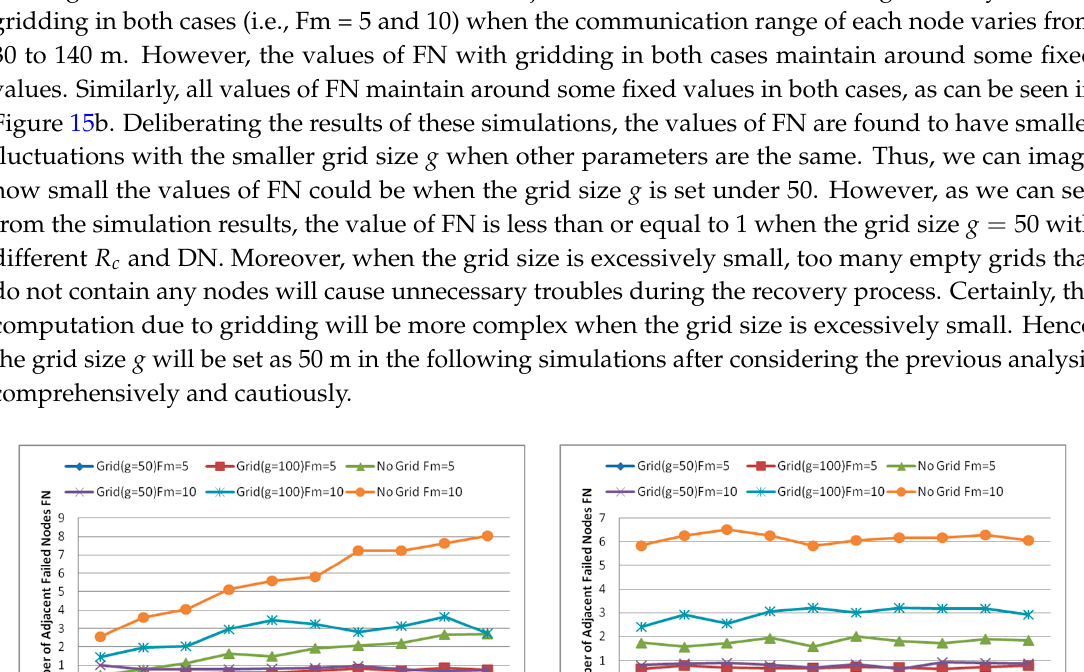
Figure 15. ( a ) FN with different (cid:1844) (cid:3030) and Fm; and ( b ) FN with different DN and Fm.